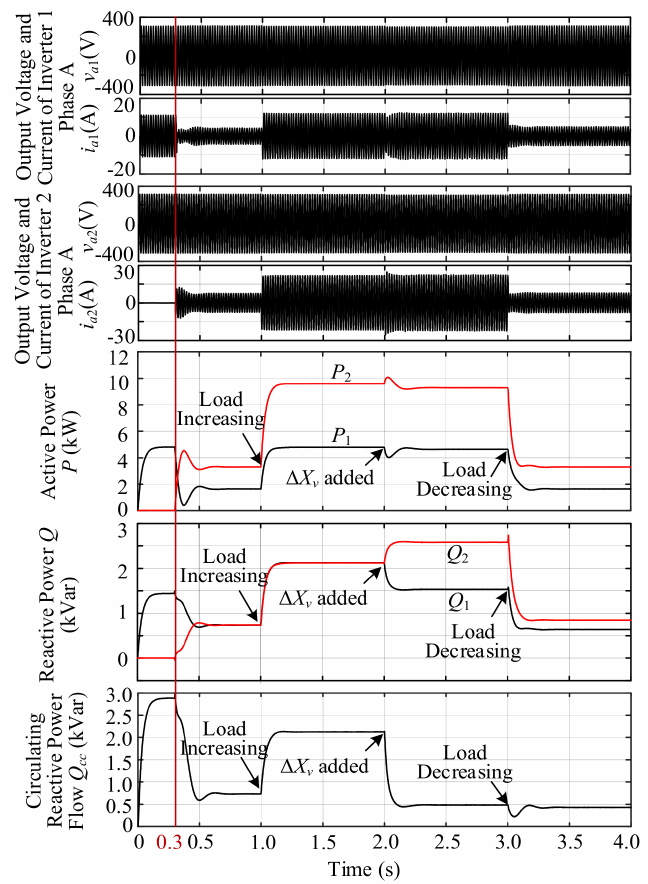
Figure 6. Simulation results of the considered system.